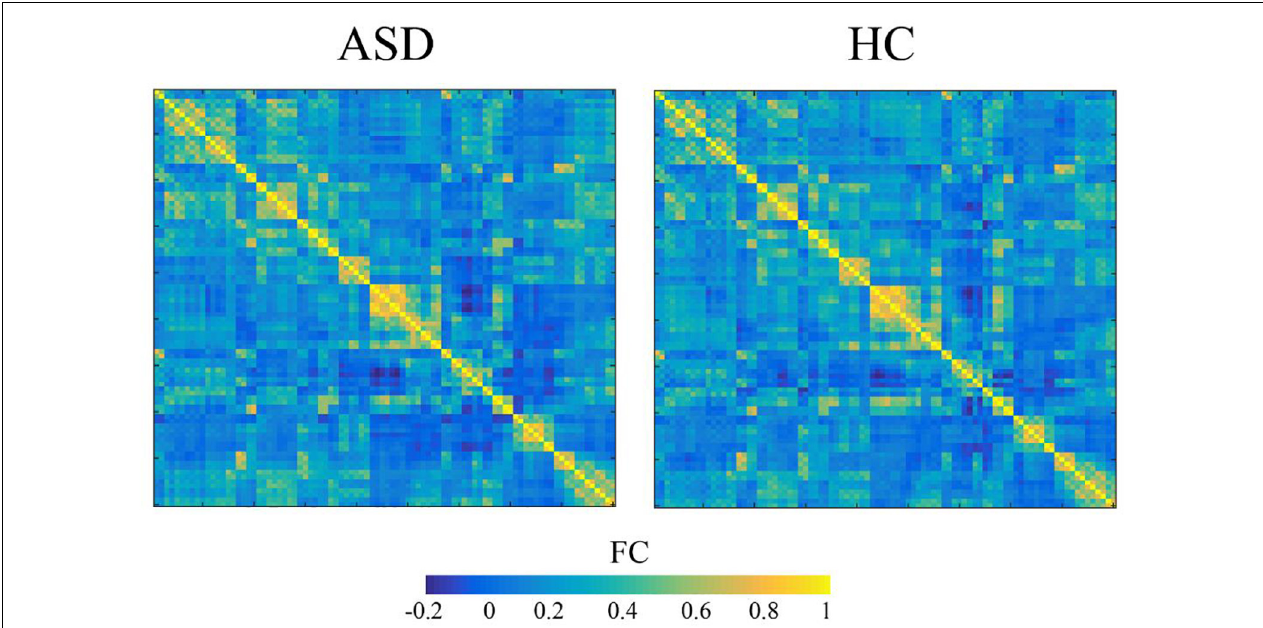
FIGURE 1 | Average functional connection matrix of the ASD group and HC